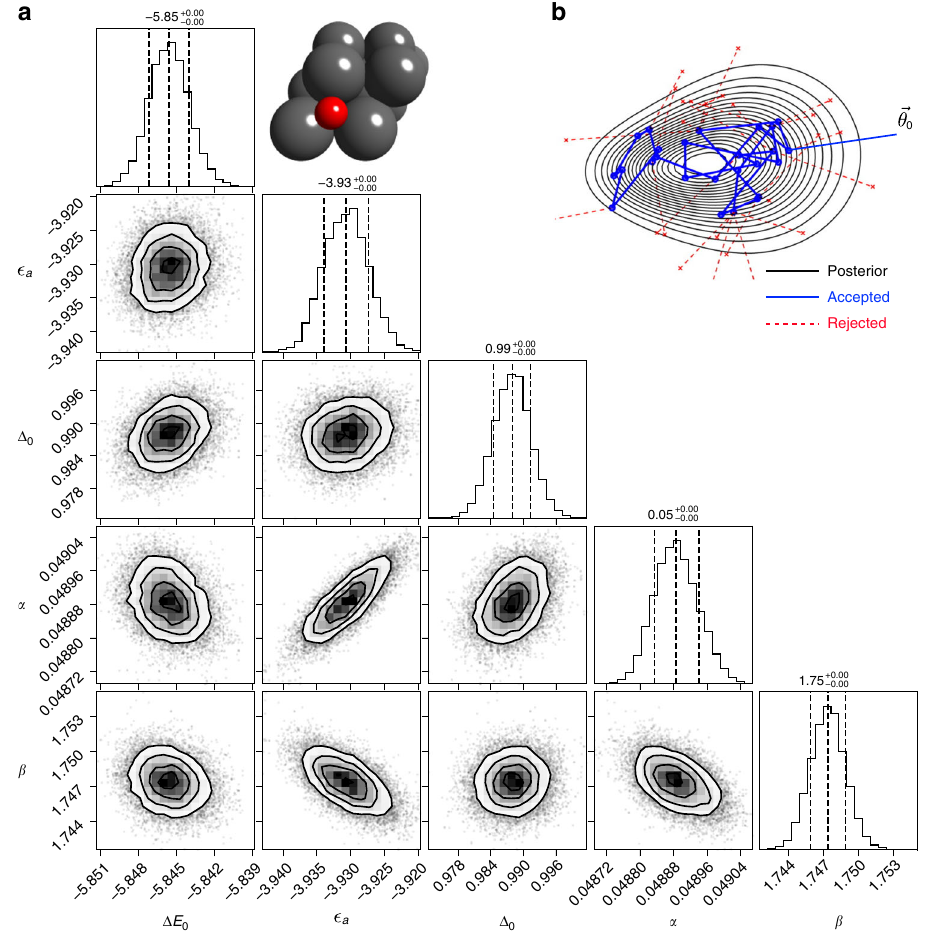
Fig. 2 Bayesian parameterization. a The co-variance of the joint posterior distribution for each parameter pair and the 1D histogram of model parameters ( Δ E 0 , ϵ a , Δ 0 , α , and β ) from MCMC simulations for *O adsorption at the fcc-hollow site of the {111}-terminated transition-metal surfaces. A top view of the model structure is shown in inset. b Schematic illustration of the MCMC sampling in a multidimensional parameter space. θ model